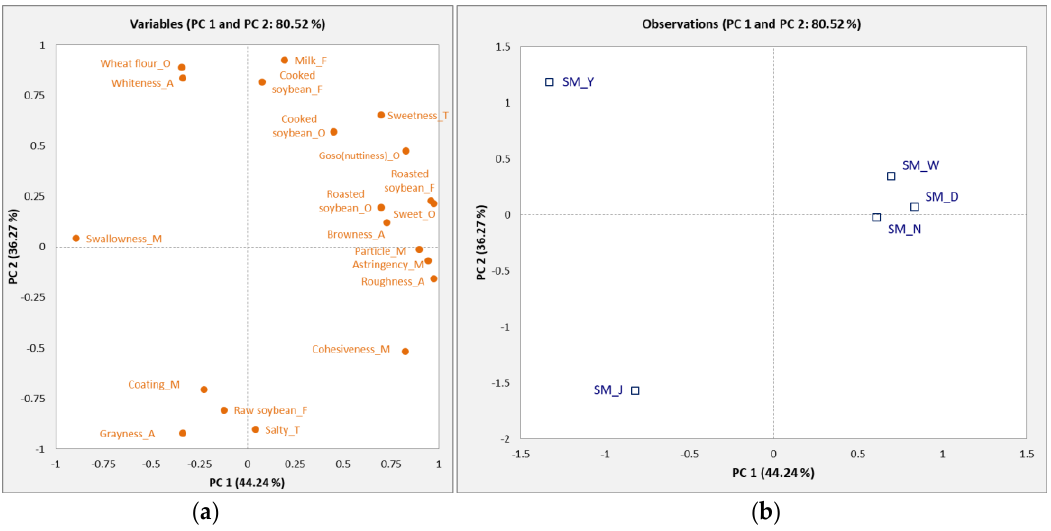
Figure 2. Principal component (PC) loadings and scores of the attributes ( a ) and five soymilk samples ( b ).